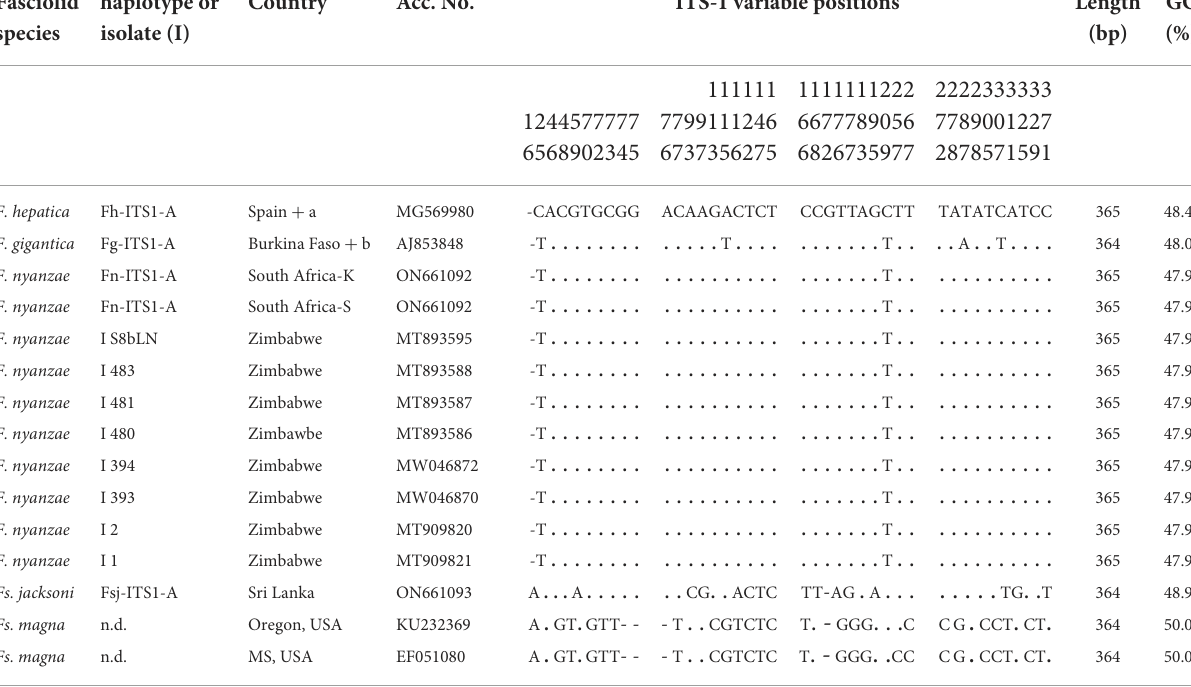
TABLE 3 Polymorphic sites in the sequence comparison of the nuclear rDNA ITS-1 between haplotypes of “genetically pure” Fasciola hepatica from livestock in Europe and the Americas, “genetically pure” F. gigantica from livestock in African countries, F. nyanzae from hippopotamuses in the nature reserves in South Africa and from snails and one hippopotamus in Zimbabwe, Fascioloides jacksoni from elephants in Sri Lanka, and Fs. magna from cervids in USA.